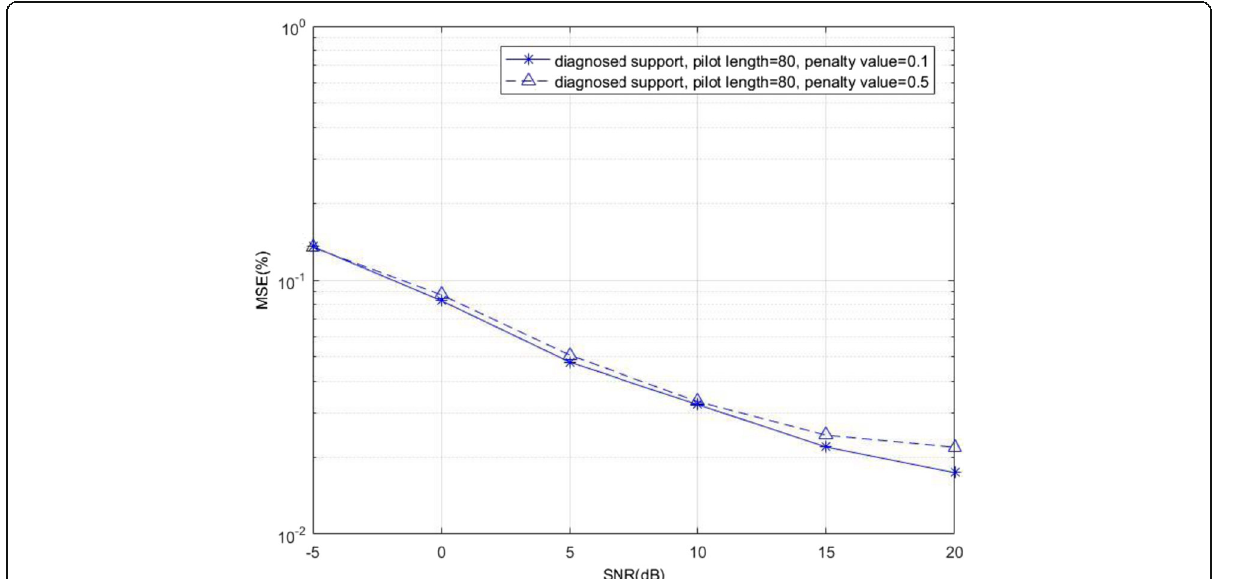
Fig. 6 Weighted SP recovery based on the diagnosed supports with different penalty